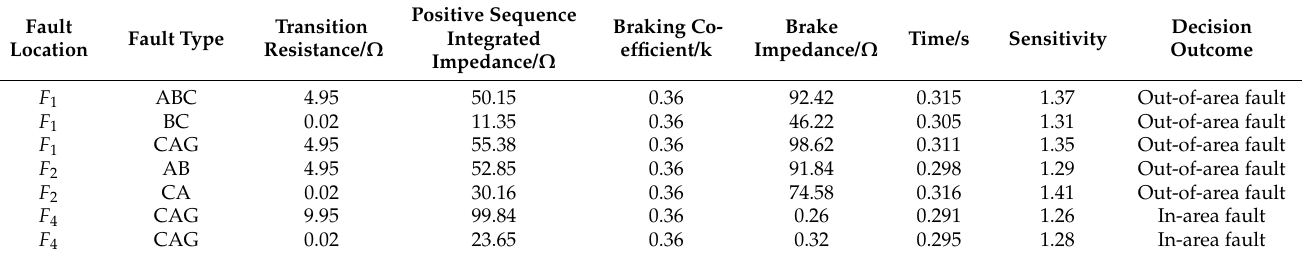
Table 4. Identification of line 9 protection at different positions and under different fault